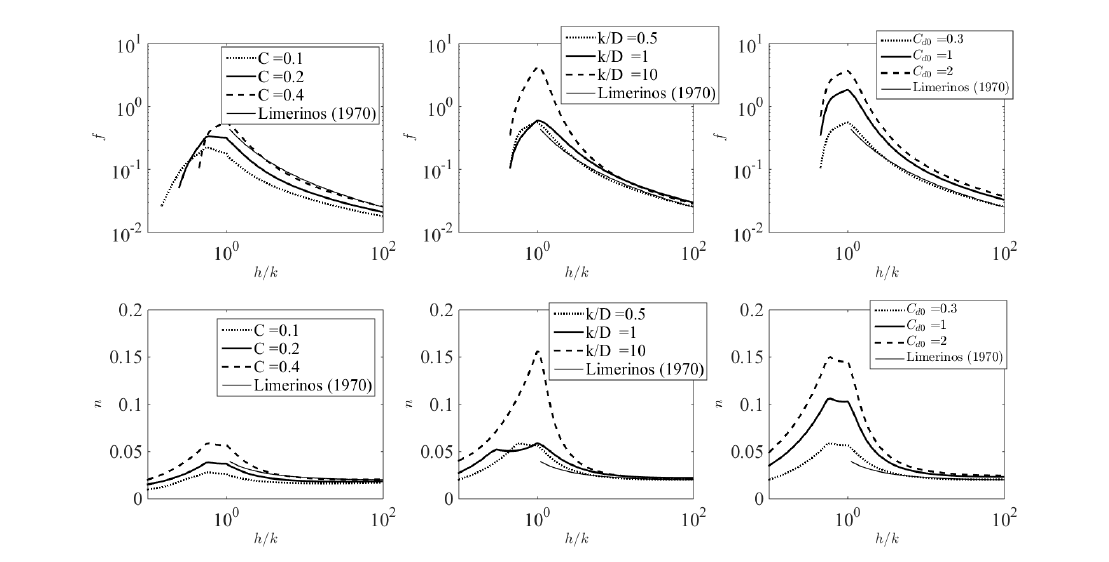
Figure 17. Friction coefficient as a function of the geometrical model parameters ( C d = 0.3, k / D = 0.5, C = 0.4 for the parameters which do not